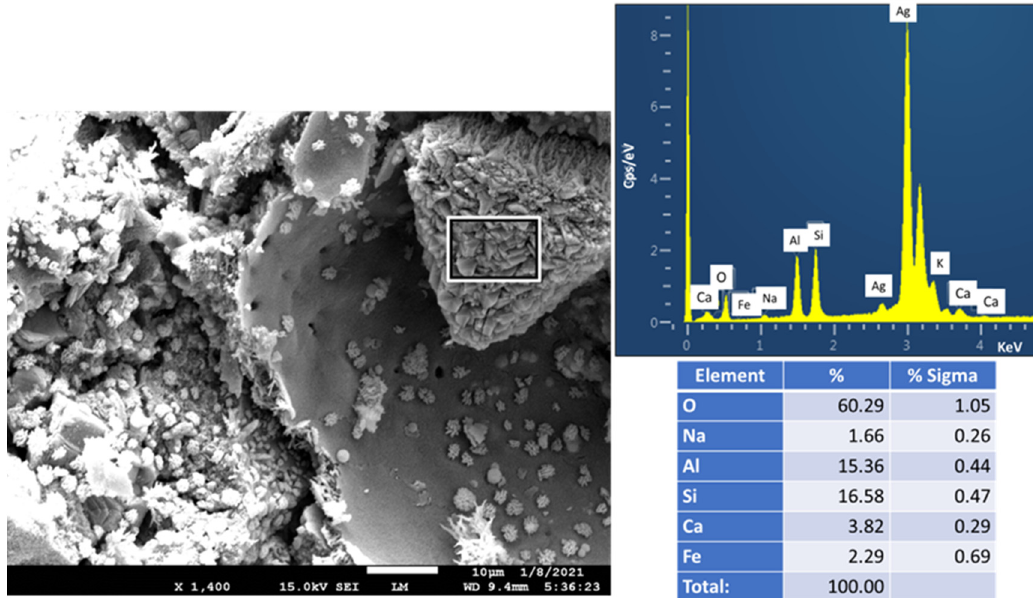
Figure 27. SEM image and EDX elemental composition of CAC blend with 3% PMHS-treated fly ash cenospheres after autoclaving for 24 h at 250 °C.